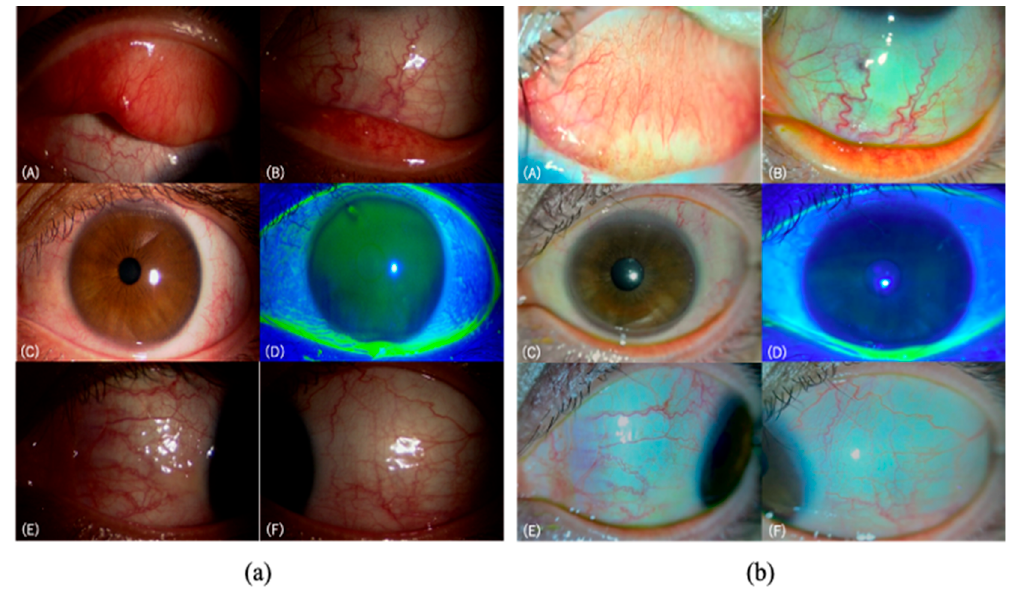
Figure 3. Representative images taken by the two devices; ( a ) the conventional slit-lamp microscope (700GL), and ( b ) the SEC. A 11-year-old female patient was diagnosed with SAC caused by orchard grass. ( A , B ) show the palpebral conjunctiva with dilatation of many vessels, localized edema, and a few papillae. There are no follicles or giant papillae. ( C , D ) show the limbus and the cornea without swelling, Trantas dot, or epithelial damage. ( E , F ) show the bulbar conjunctiva with dilatation of many vessels, and localized edema.